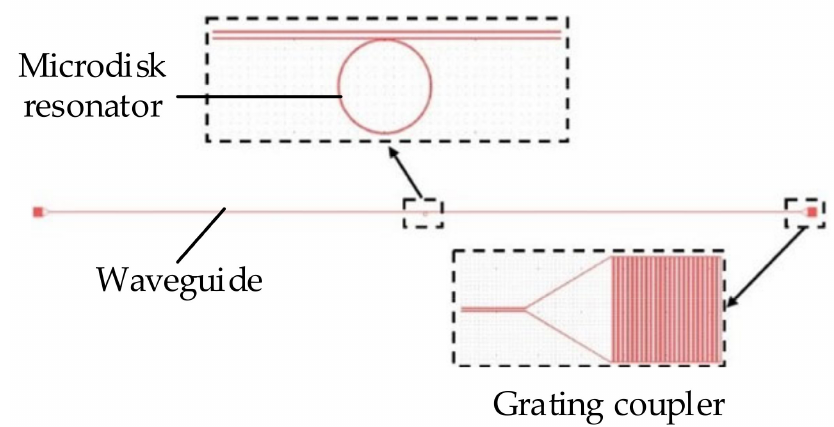
Figure 17. Exposure pattern of the micro-optical